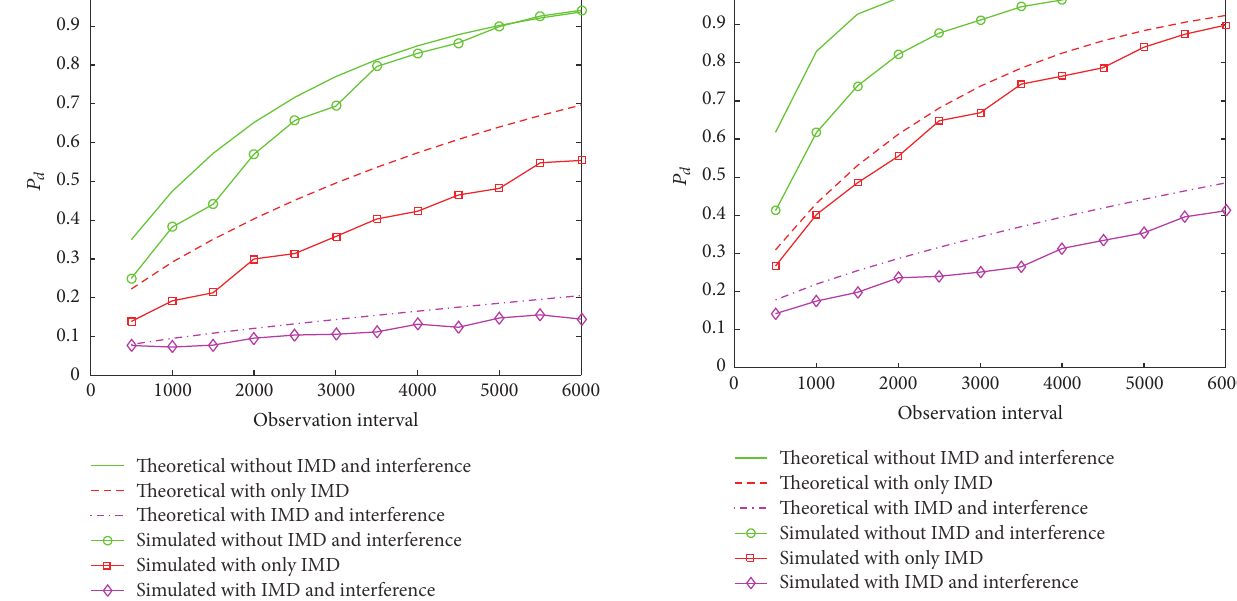
Figure 11: Observation interval versus 𝑃 𝑑 with PU at 500 m.